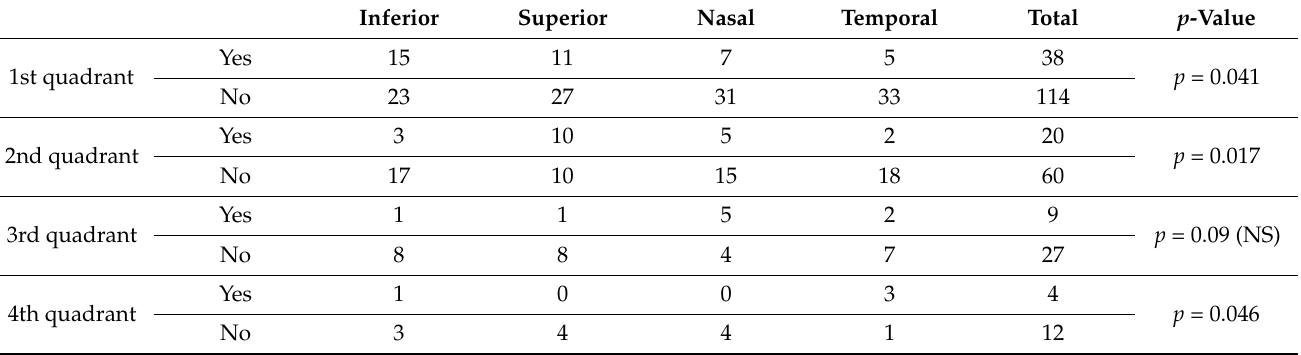
Figure 3. Diagram showing the filling patterns in neovascularization involving one, two, three and all four quadrants. Taking the four quadrants diagram as an example, the inferior quadrant is the first to fill in 67%, the superior quadrant fills second in 83% of cases, the nasal quadrant fills third in 75% of cases and the temporal quadrant is the last to fill in 67% of cases. Table 3. Agreement of ISNT rule with respect to CoNV filling patterns for central lesions.